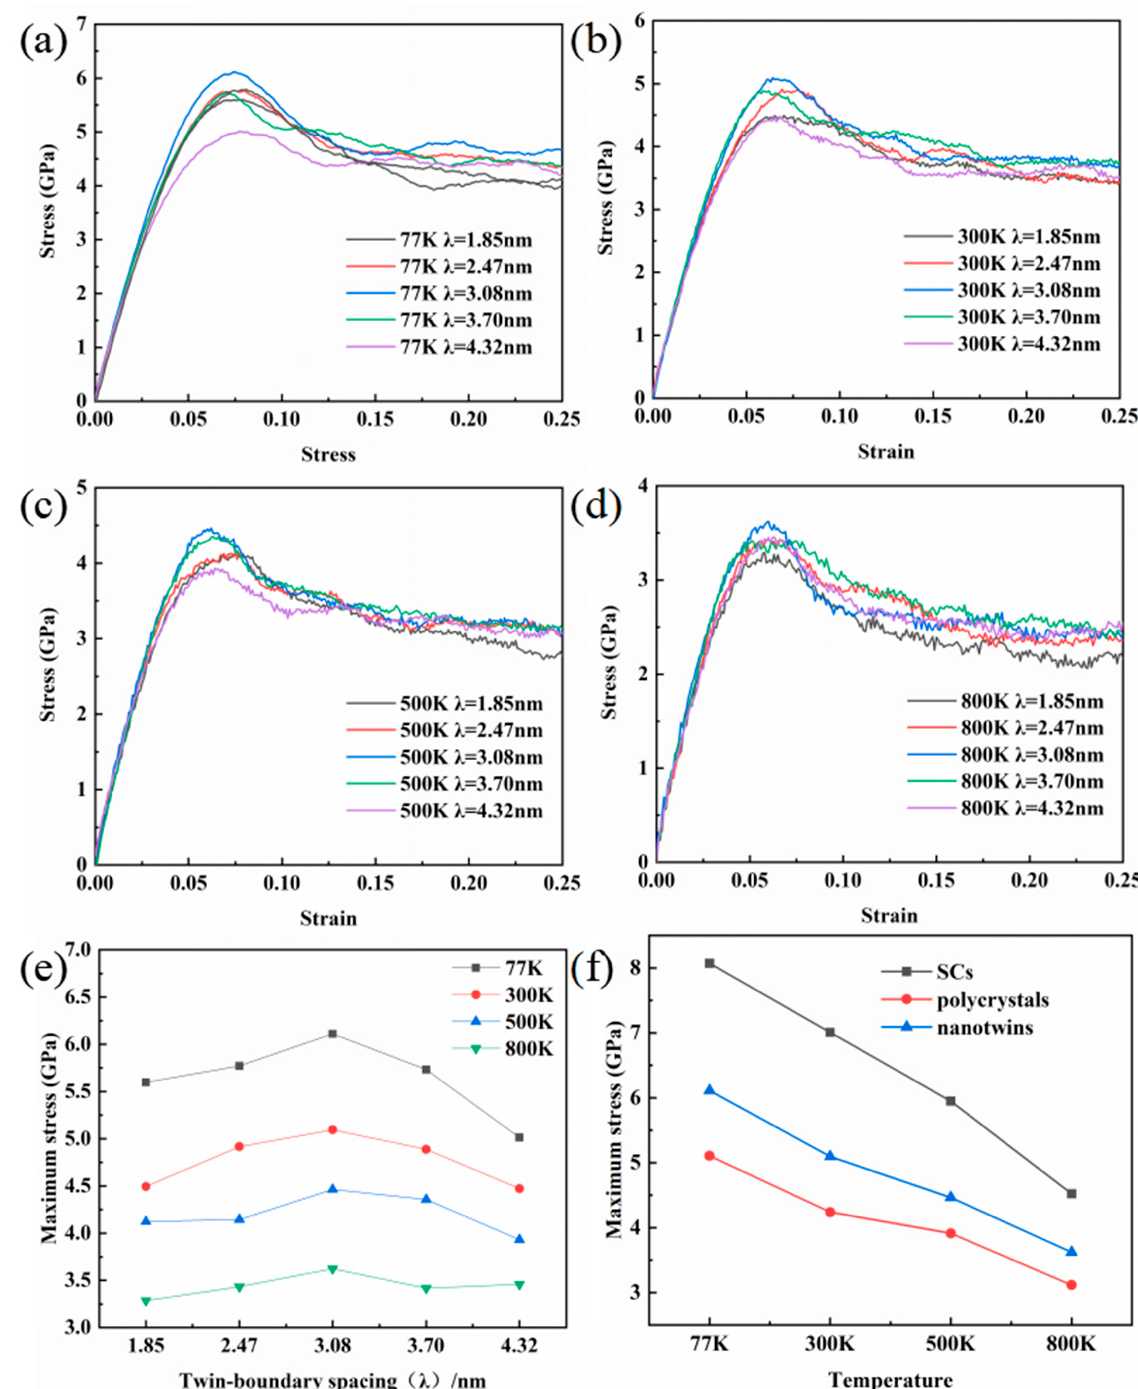
Figure 12. Stress-strain curves of samples with different TB spacing at 77 K ( a ), 300 K ( b ), 500 K ( c ) and 800 K ( d ), ( e ) maximum stress for samples with different spacing at different temperatures, ( f ) maximum stresses of SCs, polycrystals, polycrystals with nanotwins at different temperatures.